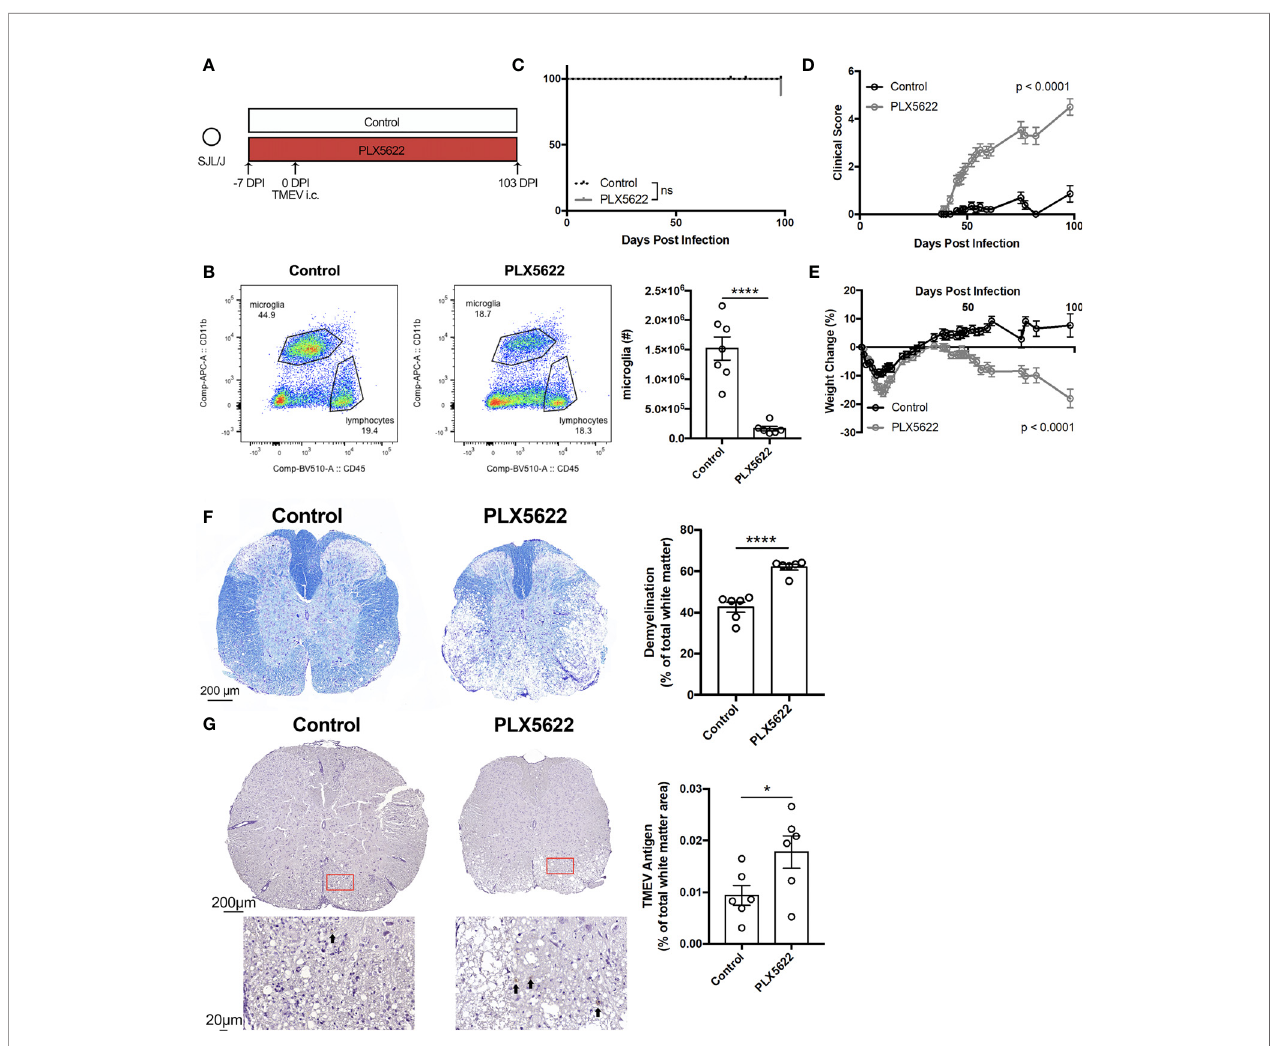
FIGURE 3 | SJL/J mice chronically treated with PLX5622 exhibit exacerbated TMEV-induced demyelinating disease. (A) SJL/J mice were treated with a PLX5622- supplemented or control diet seven days prior to i.c. TMEV infection and sacri fi ced at 103 DPI for analysis. (B) Representative fl ow plots and quanti fi cation of CNS microglia (n = at least 6 mice per group). (C) Survival, (D) clinical score, and (E) weight change corresponding to (A) (n = 20 mice per group). (F) Representative luxol fast blue staining and (G) TMEV antigen staining (arrows highlight positive staining) in thoracic spinal cord cross sections and quanti fi cation (n = 6 mice per group, at least 5 sections per mouse). Data are presented as mean ± SEM. *P ≤ 0.05, ****P ≤ 0.0001, ns, not signi fi cant; Student t test for (B, F, G) , log-rank test for (C) , and two-way ANOVA for (D, E)